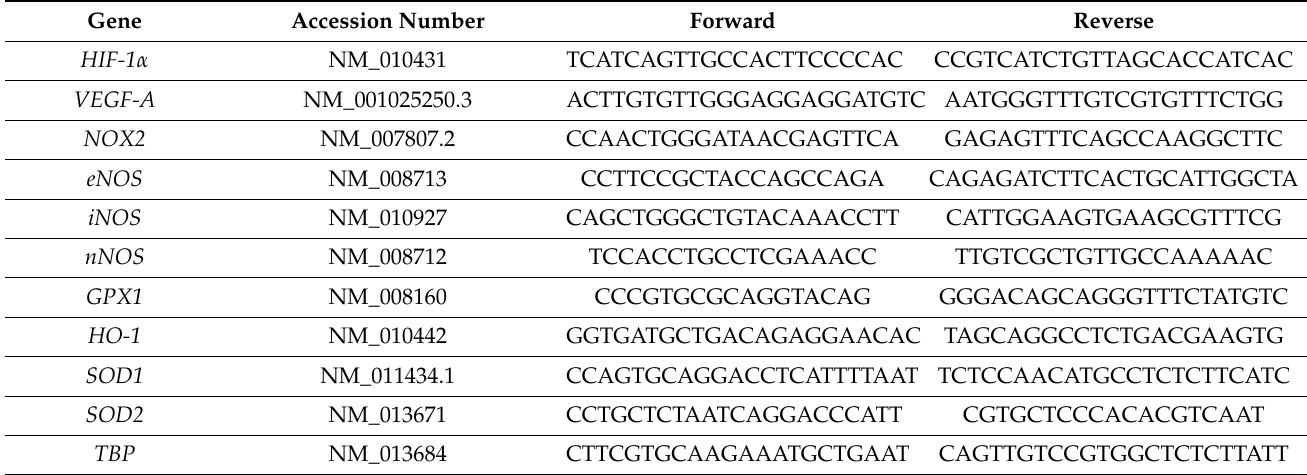
Table 1. Primer sequences used for quantitative PCR